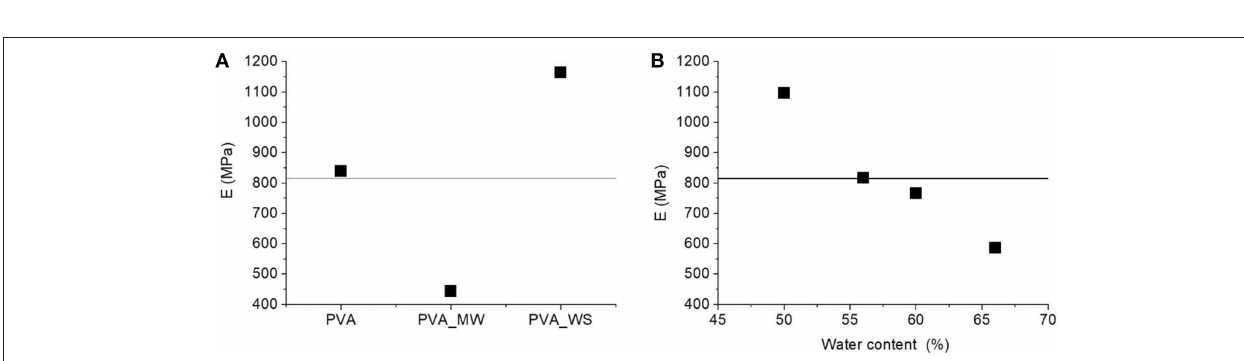
FIGURE 7 | ANOVA analysis results: average flexural modulus as a function of: (A) type of additive and (B) water amount.